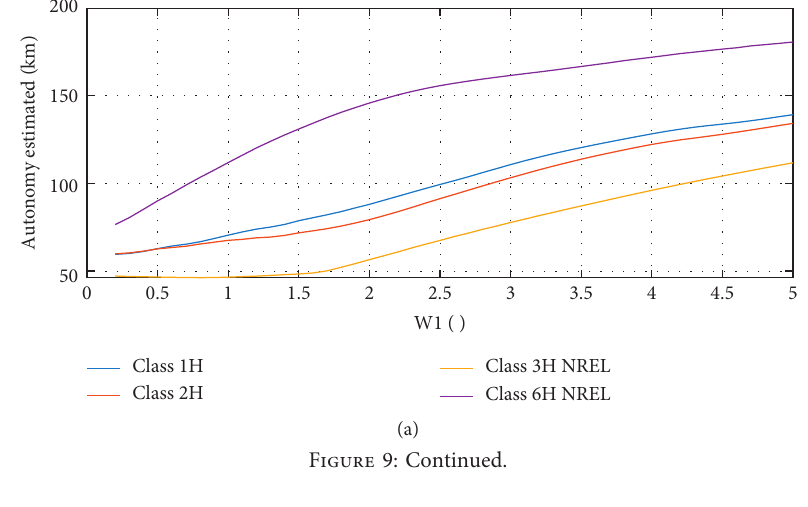
Figure 8: Energy required versus β